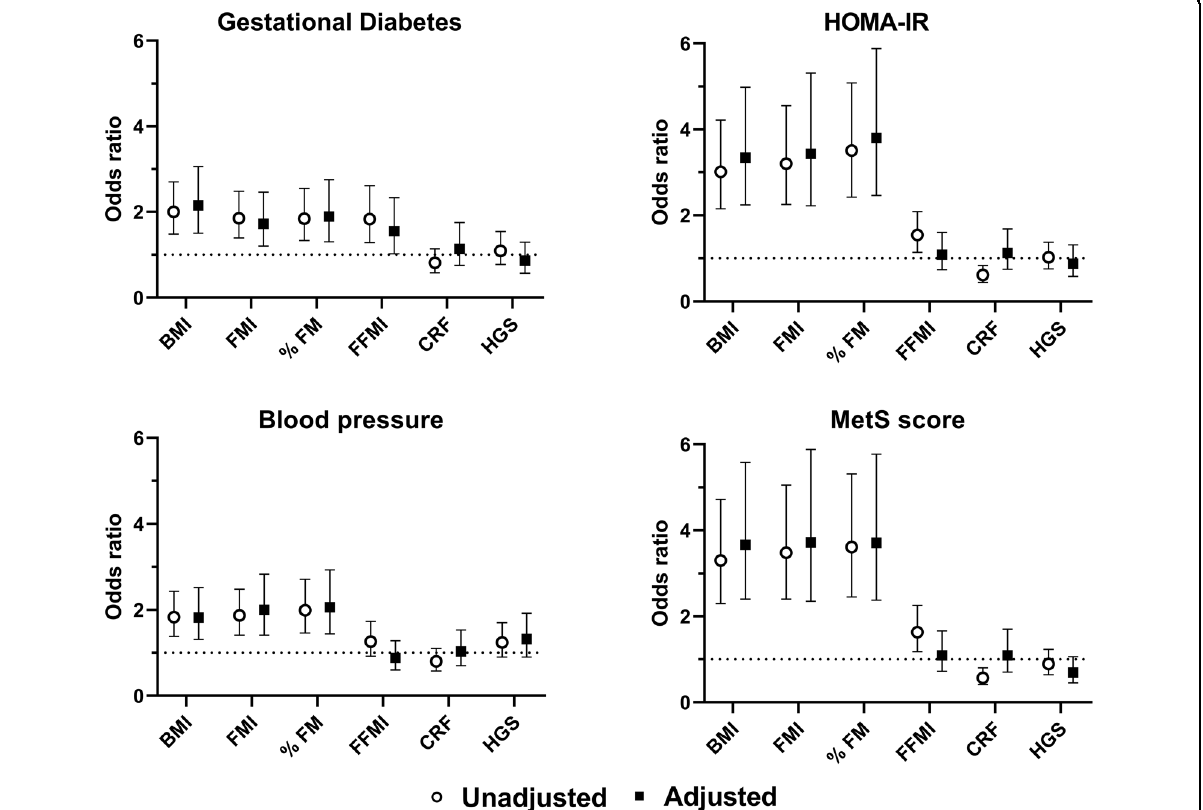
Fig. 1 Body composition, physical fi tness and cardiovascular health in early pregnancy. Odds ratios of gestational diabetes and high (de fi ned as above 1 SD above the mean) HOMA-IR, average of systolic and diastolic blood pressure and MetS score per 1 SD difference in body composition and physical fi tness variables measured in early pregnancy. Binary logistic regression was used to estimates odds ratios with 95% con fi dence intervals. Adjusted model included age, educational attainment and parity as well as cardiorespiratory fi tness, handgrip strength, FMI, and FFMI (models with BMI and % FM did not include FMI and FFMI). BMI body mass index, CRF cardiorespiratory fi tness, FM fat mass, FMI fat mass index, FFMI fat-free mass